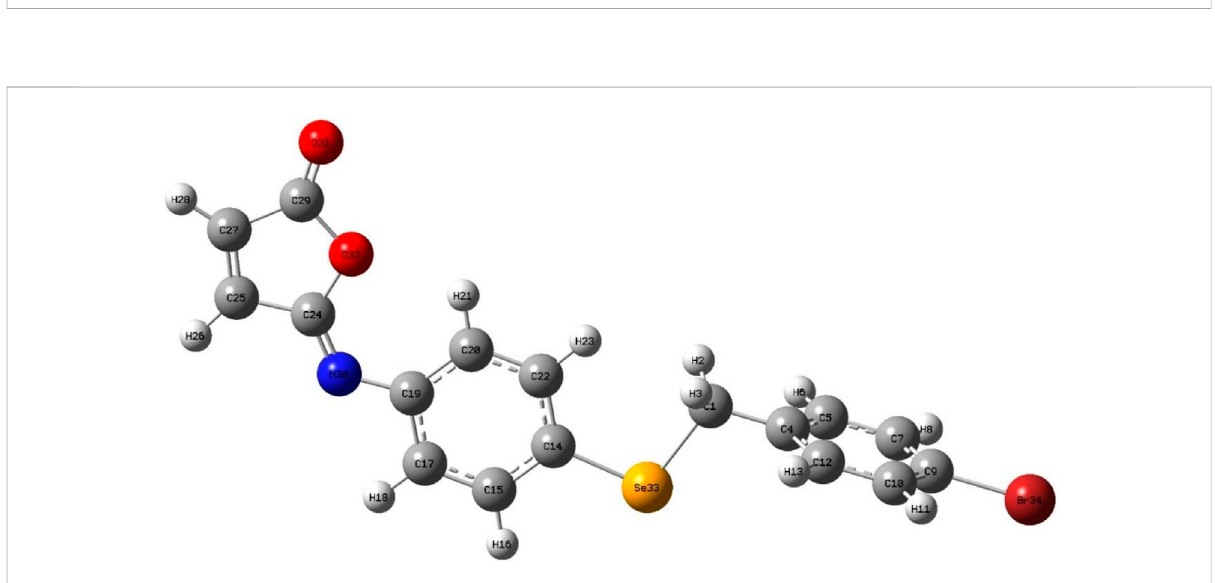
FIGURE 9 Optimized molecular structure of isomaleimide